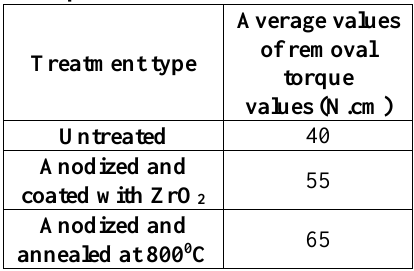
Table 3: Average values of removal torque values of untreated and treated samples after implantation for four months